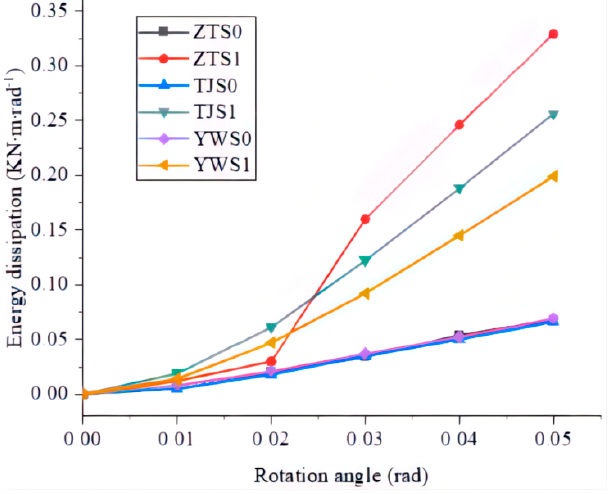
Figure 14. Comparison of energy dissipation of the joint sample at different stages.